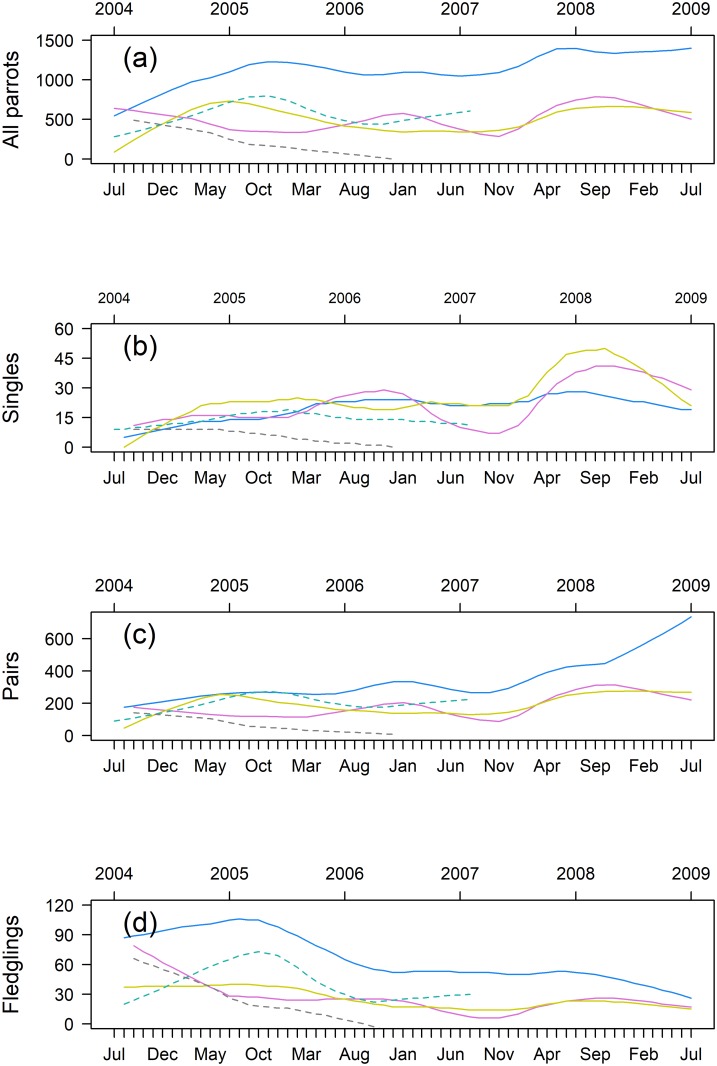
Trends obtained by the decomposition analysis of the monthly counts of Blue-fronted Amazons in five roosts (Roosts 1–5) in the southern Pantanal of Brazil, stratified by the flock sizes of parrots.(a) Counts of all parrots pooled together. (b) Counts of singleton parrots. (c) Counts of pairs of parrots. (d) Counts of family groups (3–6 birds). Blue = Roost 1, violet = Roost 2, yellow = Roost 3, green = Roost 4, and gray = Roost 5. Counts were carried out from July 2004 to July 2009.